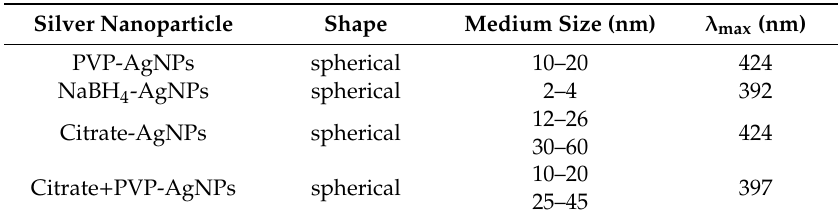
Table 1. Characterization data of the synthetized silver nanoparticles.